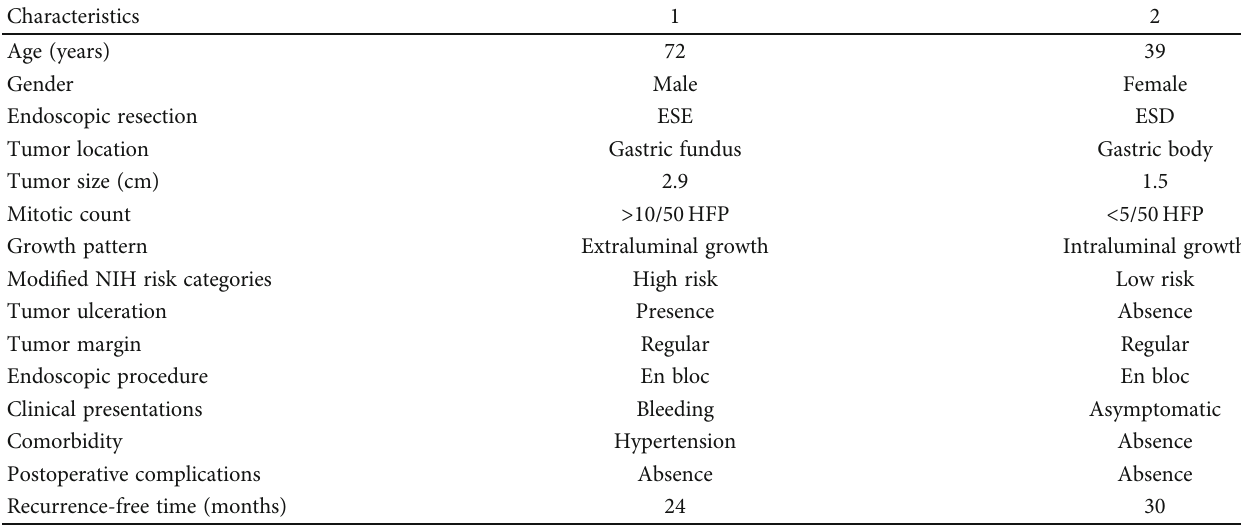
Table 4: Clinicopathological characteristics of two recurrent patients.